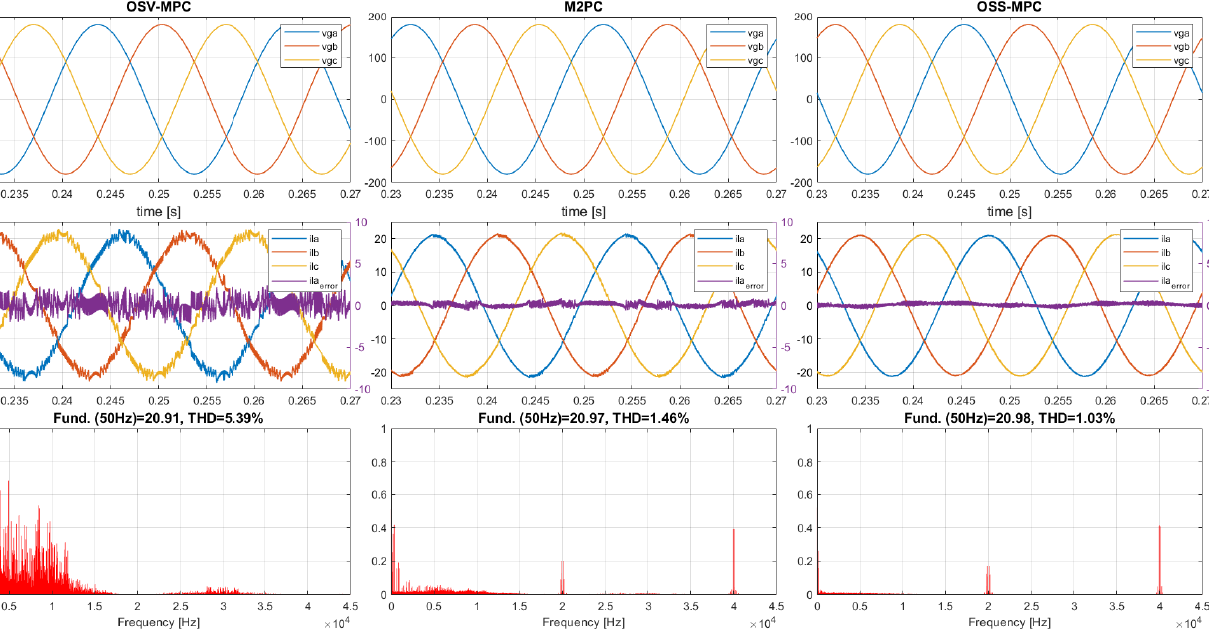
Figure 15. Output VSI line voltage and spectrum for each FCS-MPC technique for 𝑃 ∗ = 4 kW, 𝑄 ∗ = 4 kVAr. 6.1.4. Sector Selection and Duty Ratio The SVM sector selection and phase a duty ratio for OSS-MPC and M2PC with power references 𝑃 ∗ = 4 kW , 𝑄 ∗ = 4 kVAr are presented in Figures 16 and 17, respectively. The two optimizations elaborated in the OSS-MPC produce a more precise sector selection than M2PC, and then less transitions between sectors are observed for OSS-MPC. This